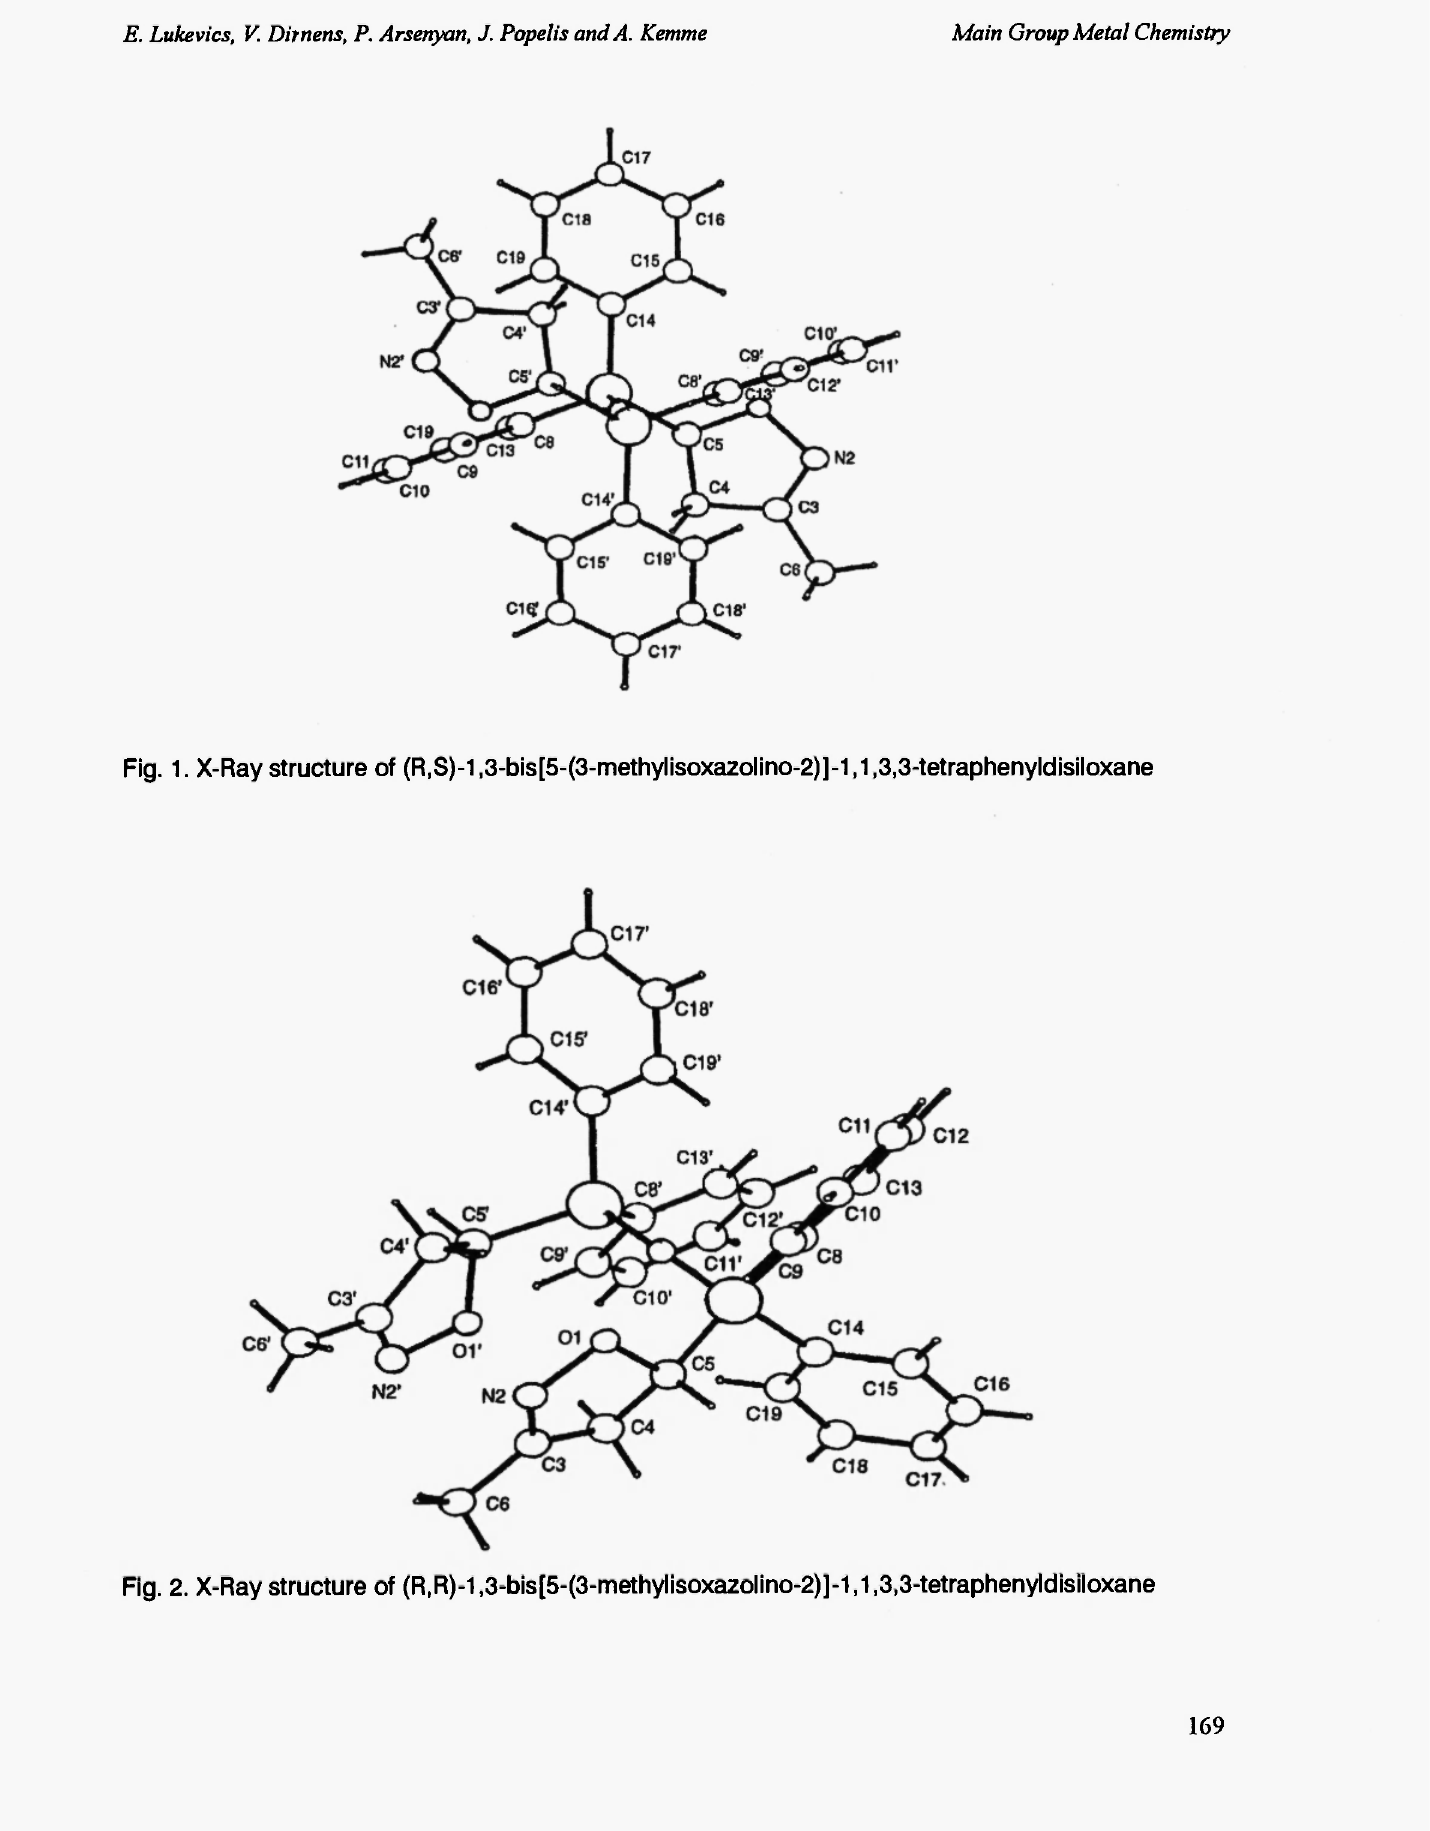
Fig. 2. X-Ray structure of